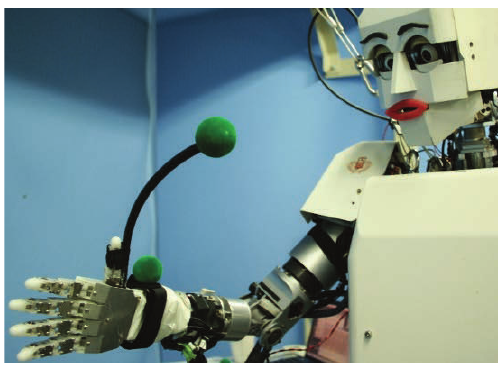
Figure 4. Kobian humanoid robot with the flexible rubber tool. Green balls (i.e. visual markers) are attached to both the wrist and the tip of the tool.